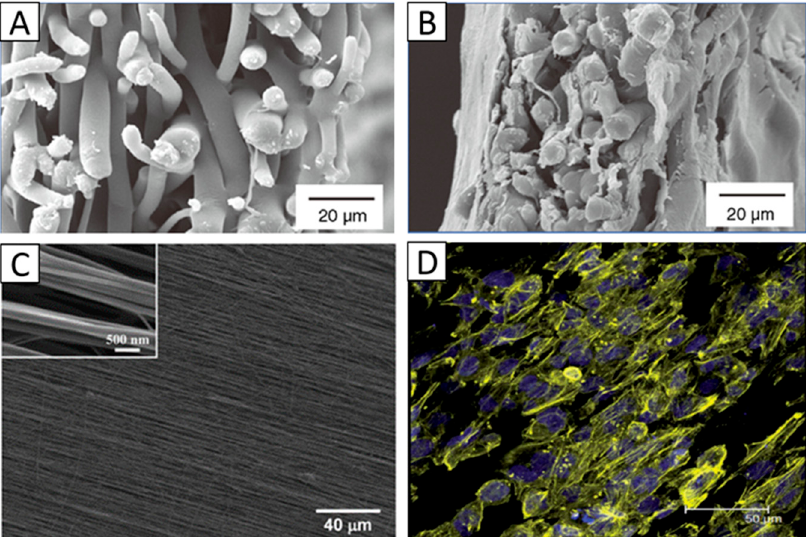
Figure 3. SEM images of randomly aligned PLGA scaffolds: ( A ) Cross ‐ sectional view of cell ‐ free scaffolds; ( B ) Cross ‐ sectional view of scaffolds cultured with limbal epithelial cells for 14 days. Panels ( A , B ) Reproduced from [47], With permission from © 2010 Future Medicine; ( C ) SEM image of aligned fibrous PEUU scaffold. Reproduced from [8], with permission from © 2012 Elsevier; ( D ) Stained human corneal epithelial cells with DAPI (blue, nuclei) and phalloidin (yellow, F ‐ actin) after three days of culturing on the aligned PGS/PCL nanofibrous scaffolds. Reproduced from [53], with permission from © 2014, The Royal Society of